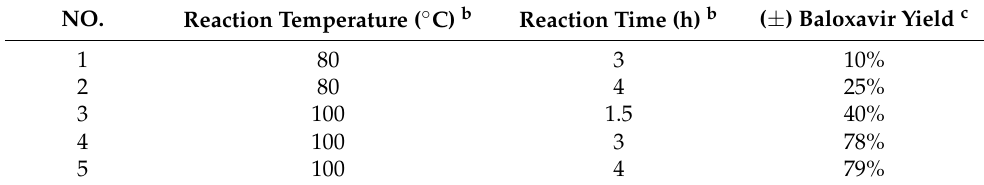
Table 4. Screening of ( ± ) baloxavir a